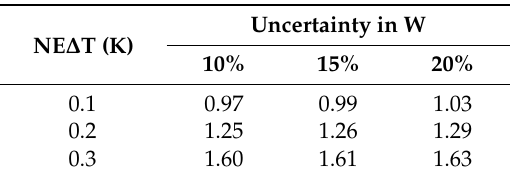
Table 5. The total RMSEs (K) related to different NE ∆ Ts and uncertainties in W, assuming 1% uncertainties in (1 − ε ) and ∆ ε